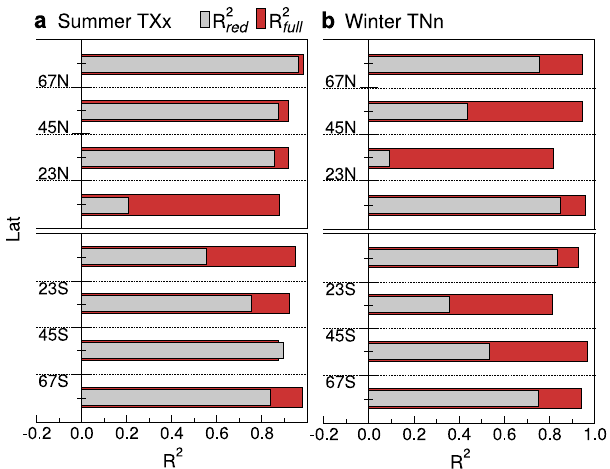
Fig. 4 | Contributions of the leading moments to the extremes. Zonal decom- positionofthe coef fi cients of determination R 2 of the warming ratesofthe hottest days ( TXx ) and the coldest nights ( TNn ) in the summer ( a ) and the winter hemi- spheres( b ),respectively,at+2Kwarming.AsinTable1, R 2 red accountsforchangesin the averages alone whereas R 2 full accounts for the fi rst two moments (excluding skewness and next order